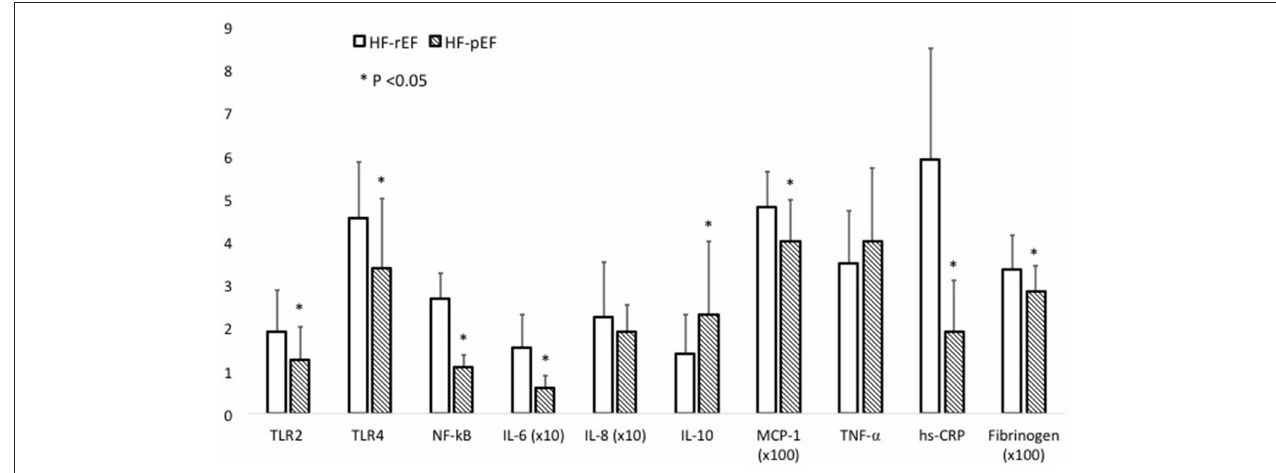
FIGURE 3 | This figure graphically describes inflammatory parameter differences between the HF-rEF and HF-pEF groups. For some parameters the values are expressed as × 10 or × 100, as indicated. Comparisons between groups were made using a student’s t -test. N = 50 for each study group. For Elisa assays samples